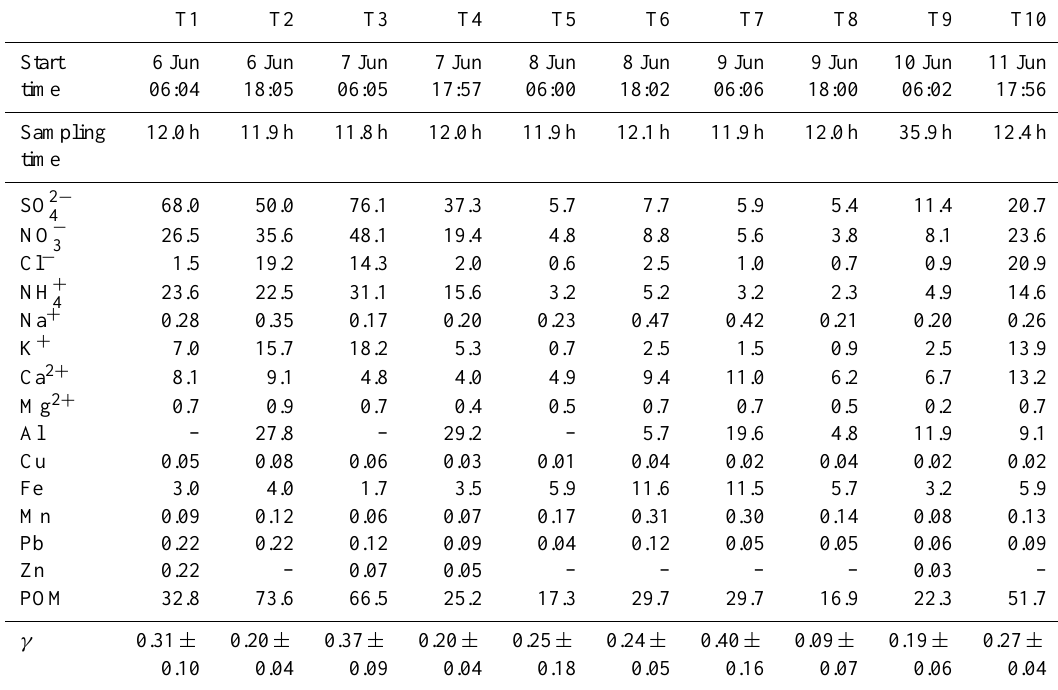
Table 3. Concentrations (µgm − 3 ) of the measured components in sampled particles (TSP) at Mt. Tai, together with measured uptake coefficients ( γ ) in this